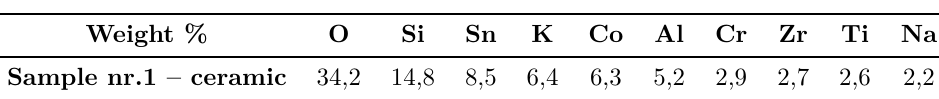
Table 1. Chemical composition of the ceramic part of the crown obtained by EDX analysis